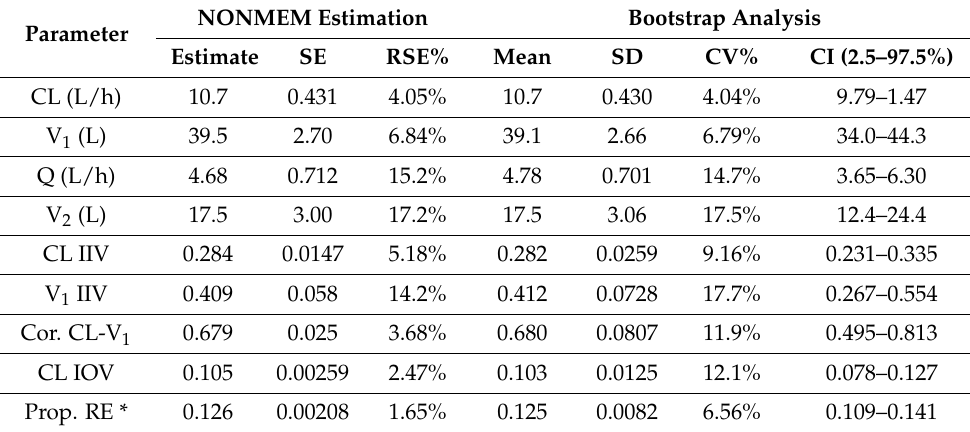
Table 3. Parameter estimates using the final covariate PopPK model.